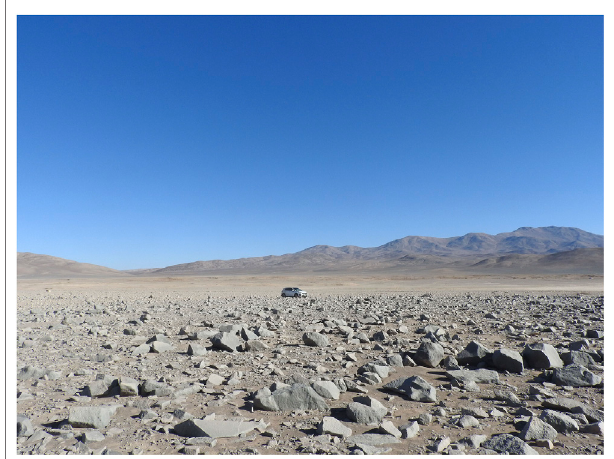
FIGURE 11| Yungay, located in the hyperarid core of the Atacama. This site, reported by NASA in 2003, although not the driest, is one of the best studied on the Atacama as analog of